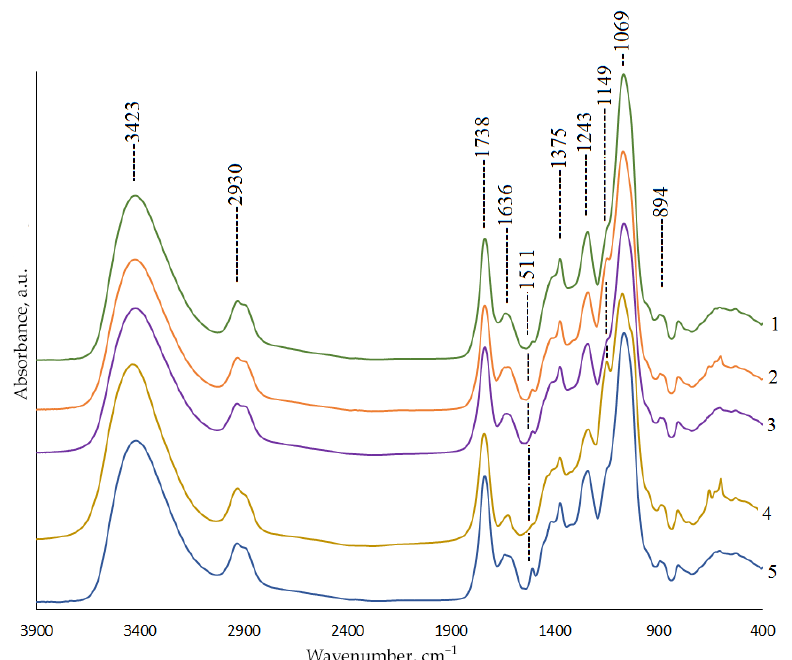
Figure 3. IR spectra of the hemicelluloses obtained by the oxidative delignification of spruce wood with (1) the (NH 4 ) 6 Mo 7 O 24 , (2) MnSO 4 , (3) TiO 2 , and (4) H 2 SO 4 catalysts and (5) without them.